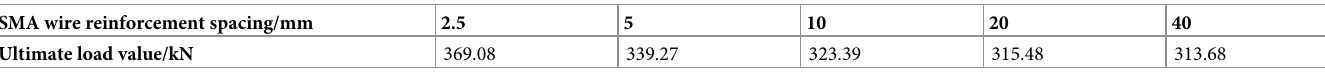
Table 13. Ultimate load values of specimens with different reinforcement spacing of